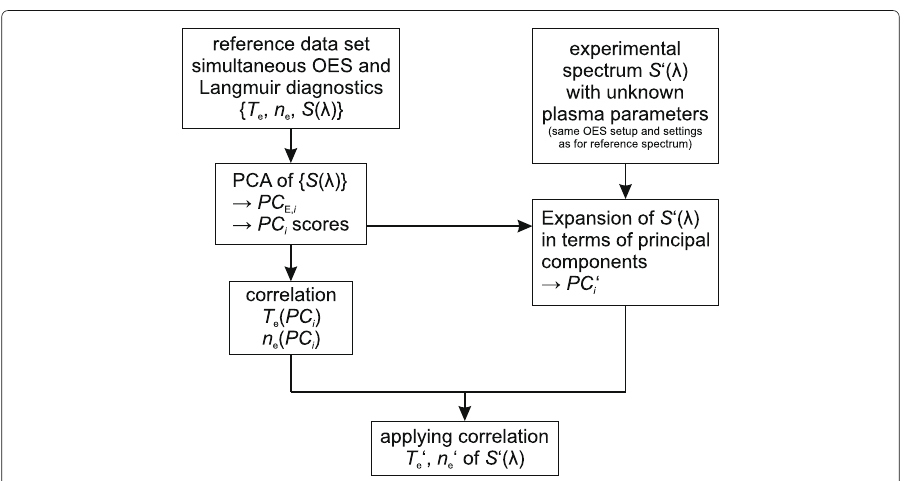
Fig. 2 Schematic description of our measurement-based correlation between optical emission spectrum and plasma parameters. First, a reference data set is measured consisting of simultaneously performed OES and Langmuir diagnostics. The measured spectrum is transferred into a simplified coordinate system using PCA, which yields the axes PC E, i and the coordinates or scores PC i of the spectra on these axes. The scores PC i are then correlated with the measured plasma parameters. The correlation can then be used to extract plasma parameters from a measured spectrum S (cid:2) (λ) by calculating its scores PC (cid:2) i and inserting them into the